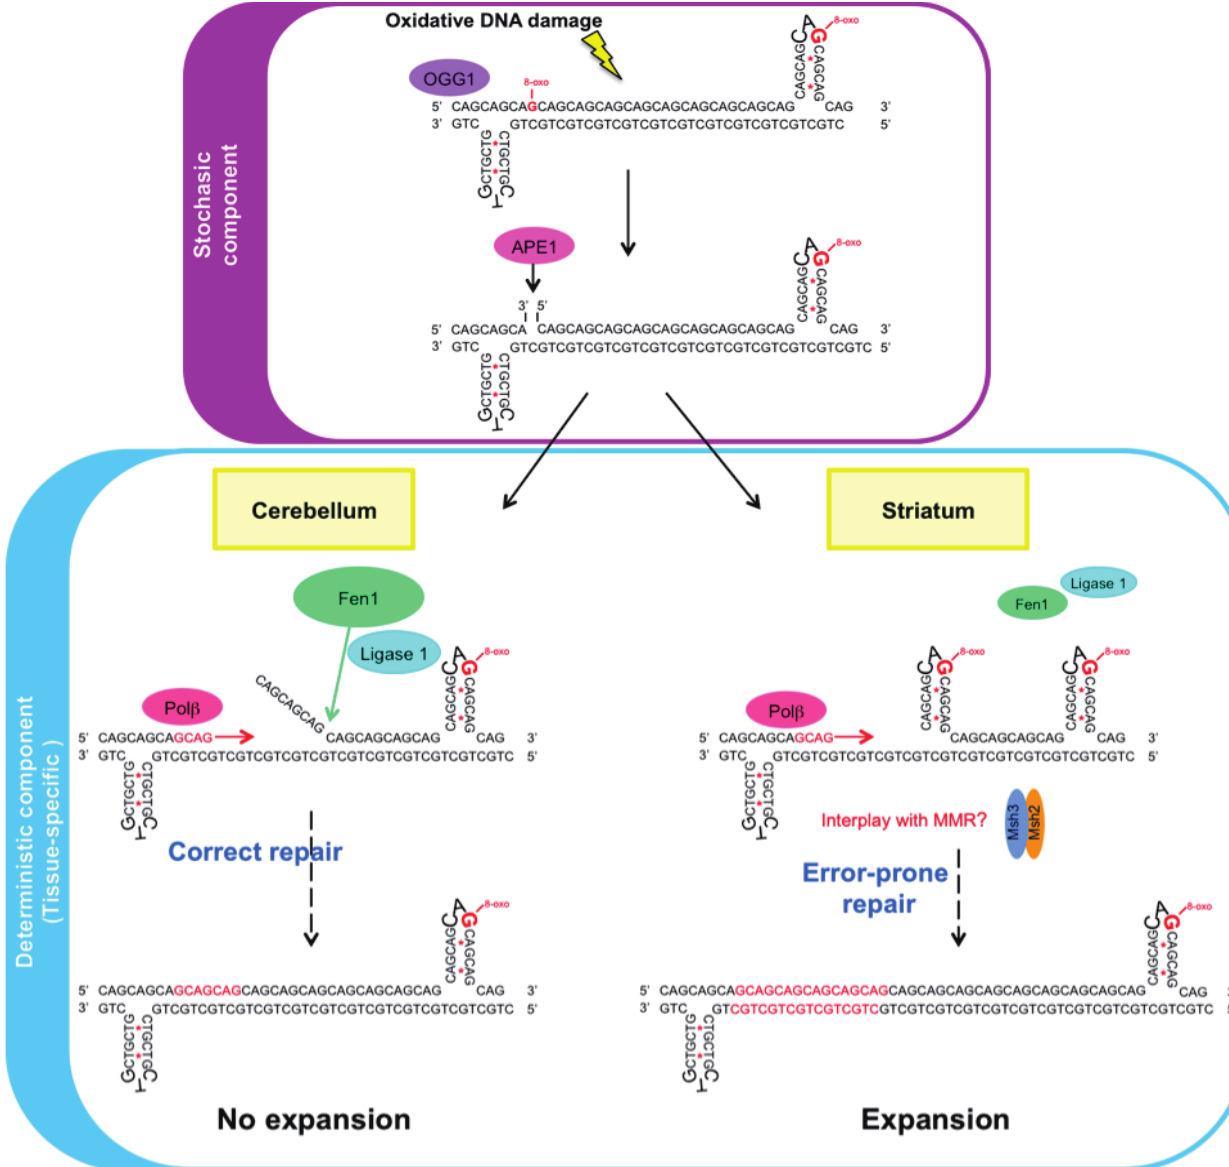
Figure 1. Base excision repair (BER)-induced CAG repeat expansion is tissue-dependent. Oxidative DNA lesions, including 8-oxoG lesions, occur stochastically at trinucleotide CAG repeats and are processed by the BER pathway. A DNA glycosylase (e.g., Ogg1) and Ape1 initiate repair. Repair outcome (“no expansion” or “expansion”) is dependent upon the location of the lesion and the tissue that is repaired. In the cerebellum, where Fen1 and Lig1 are abundant, the DNA lesion at CAG repeats is correctly repaired: the flappy structure resulting from multinucle otide incorporation by Polβ during long-patch (LP)-BER by Fen1 is efficiently processed, and the subsequent ligation step does not result in expansion. In contrast, in the striatum, where Fen1 and Lig1 proteins are reduced, repair of the DNA lesion at CAG repeats is error-prone. The flappy structure is not efficiently processed, which ultimately leads to repeat expansion through a yet unknown mechanism. Additional DNA repair pathways, including mismatch repair (MMR), might interplay with BER during this